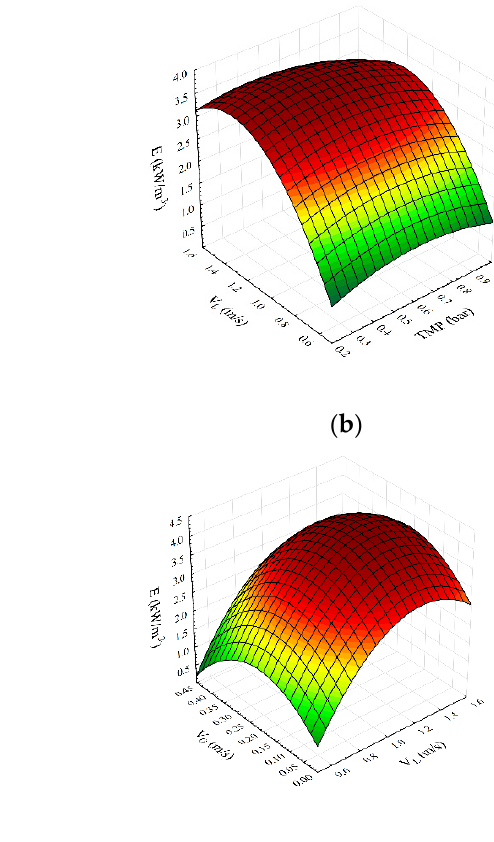
Figure 1. Parity plot ( a ) and response surface plots ( b – d ) representing the regression model for